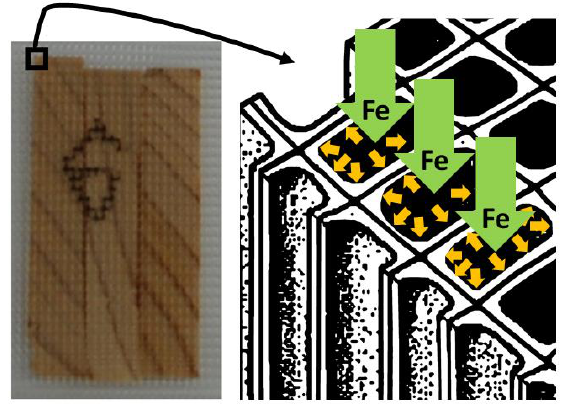
Figure 1. Left—1 cm wide specimens in nylon mesh. Right—magnified view schematic of iron complexes diffusing quickly through lumen water (large green arrows) and subsequently into cell walls, the focus of this study (small orange arrows).